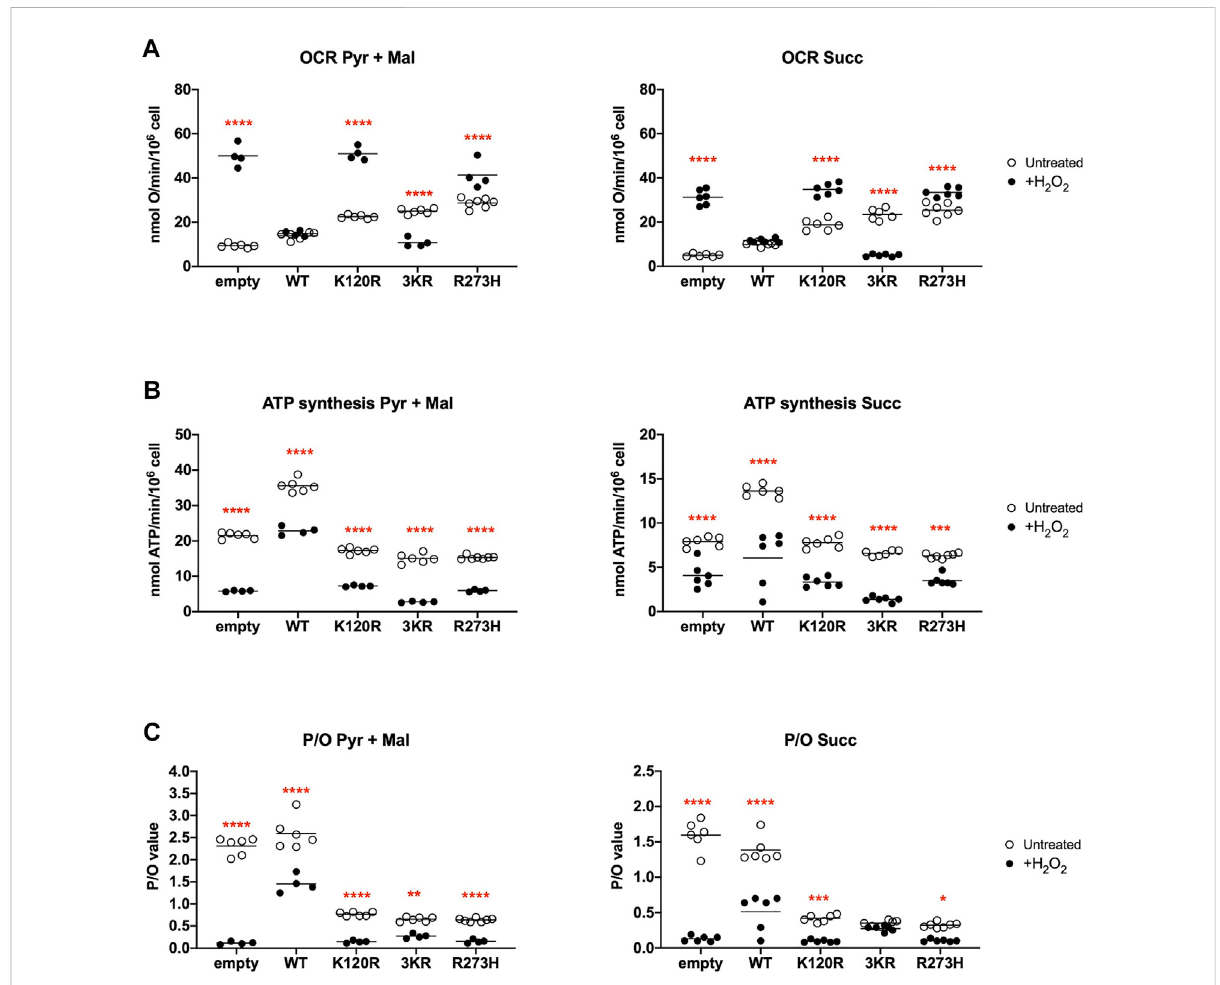
FIGURE 5 Comparison of OxPhos function in H 2 O 2 treated HCT116 TP53 − / − cells with untreated cells, expressing p53 WT , p53 3KR , p53 K120R , and p53 R273H proteins. (A) OCR in untreated (empty dots) and 100 μ M H 2 O 2 treated (black dots) cells in the presence of Pyruvate (Pyr) plus Malate (Mal) or Succinate (Succ). (B) ATP synthesis through the F o -F 1 ATP synthase in the same condition as above. (C) OxPhos ef fi ciency as P/O ratio in the same condition asabove.Each panel isrepresentativeofatleastfourindependentexperiments anddataare reportedas mean. Theredsymbols*,**, *** and **** indicate signi fi cant differences for p = 0.0110, p = 0.0026, p ≤ 0.0003 and p < 0.0001, respectively, between the untreated and 100 μ M H 2 O 2 treated samples. In each panel, the empty dots represent the data from untreated samples depicted in Figure